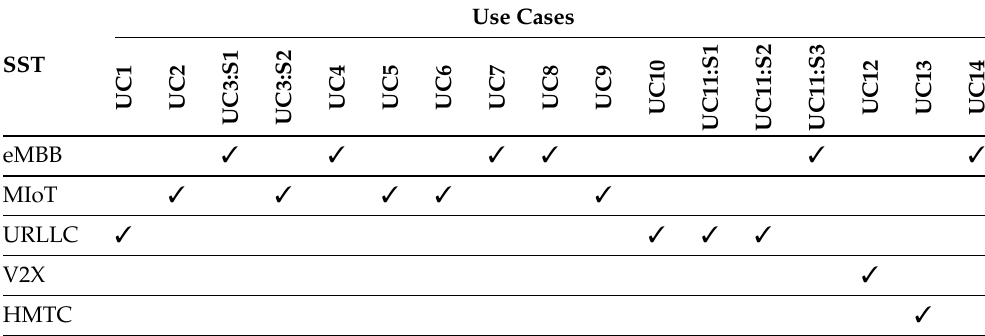
Table 4. SST supporting analyzed use cases.